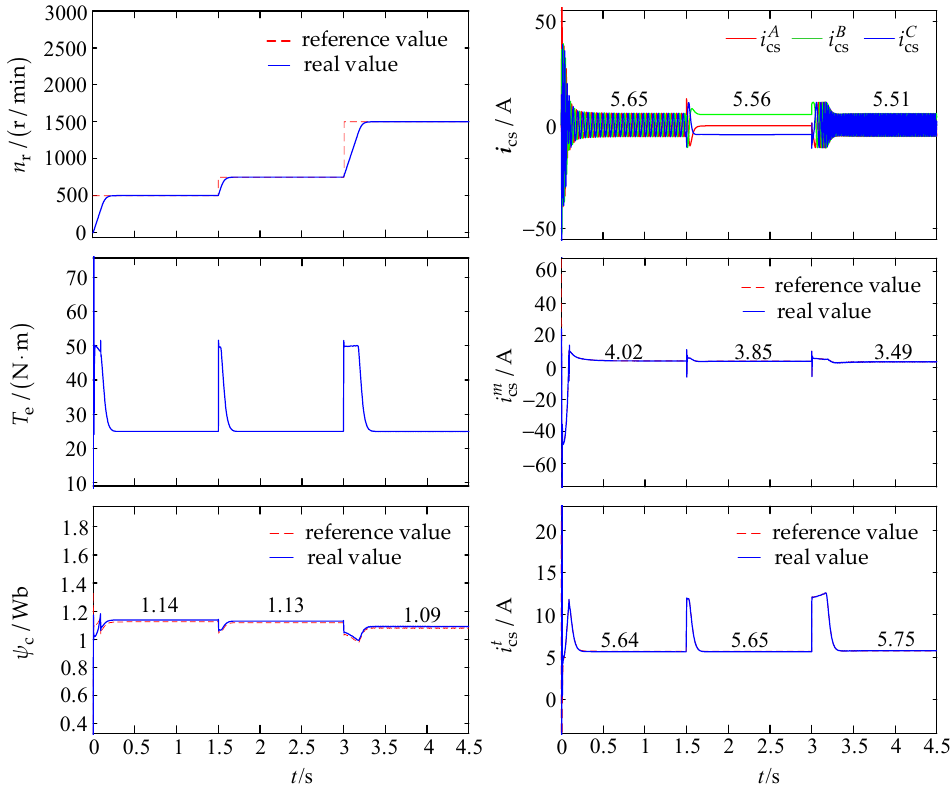
Figure 18. Simulation results of robustness verification of MTPA control when speed changes.